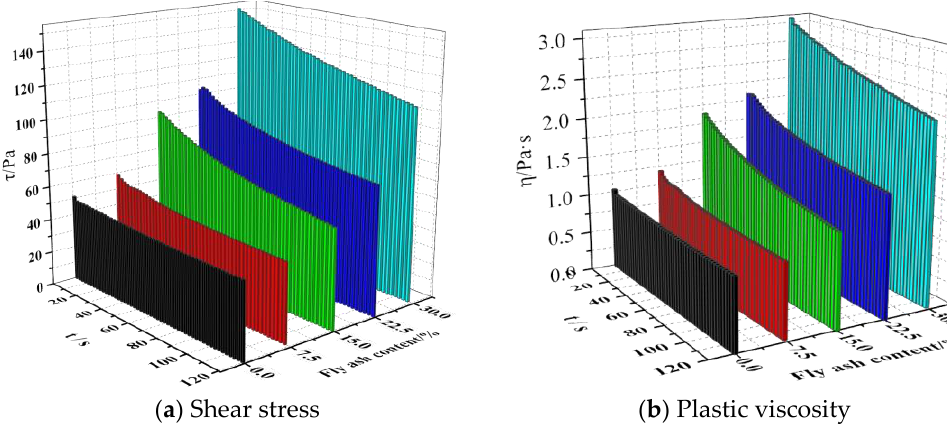
Figure 8. Rheological curve at constant shear